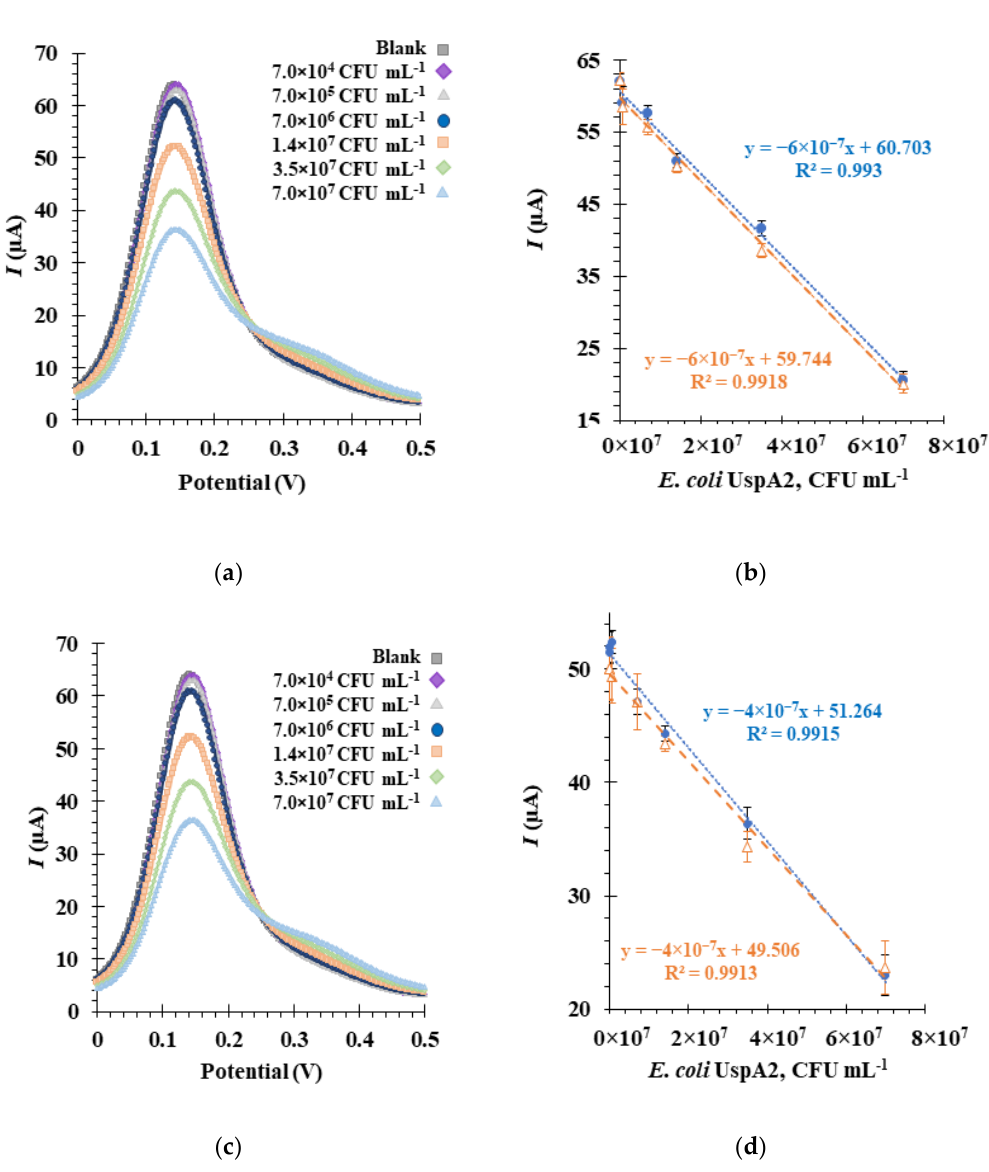
Figure 7. Electrochemical assays to assess the analytical response of the aptasensor in square wave voltammetry (SWV) ( a , c ), and the corresponding calibration curves ( b , d ), in 5.0 × 10 −3 M [Fe (CN) 6 ] 3− and 5.0 × 10 −3 M [Fe (CN) 6 ] 4− in phosphate buffer, pH 7.4. The aptasensors functionalized with Apt1_RC were incubated sequentially with increasing concentrations of inactivated Escherichia coli UspA2 cells in a buffer at pH 5.0 ( a , b ) or at pH 7.4 ( c , d ). The orange and blue plot lines ( b , d ) represent calibration curves performed on different days.